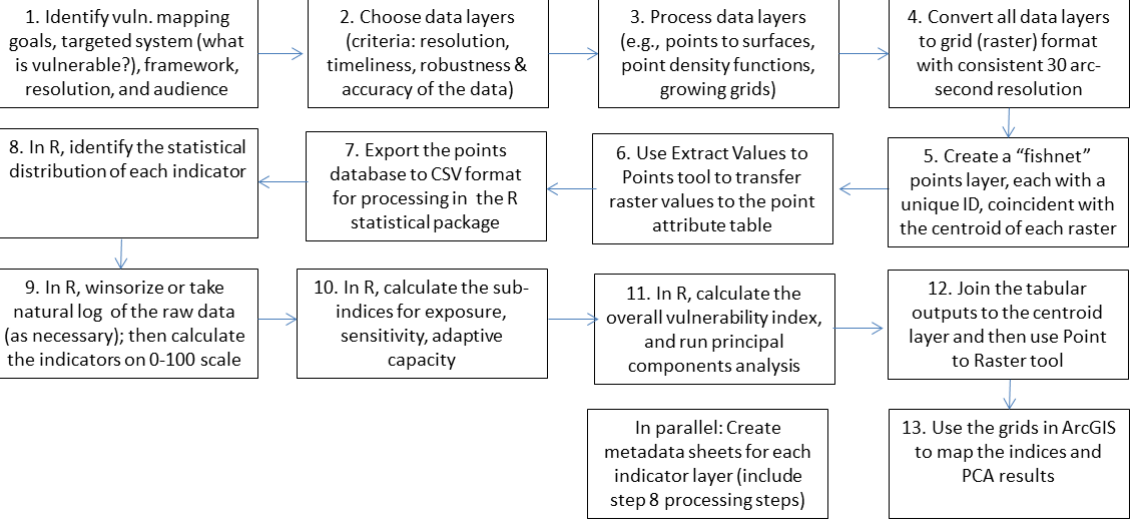
Figure 1. Vulnerability mapping processing flow